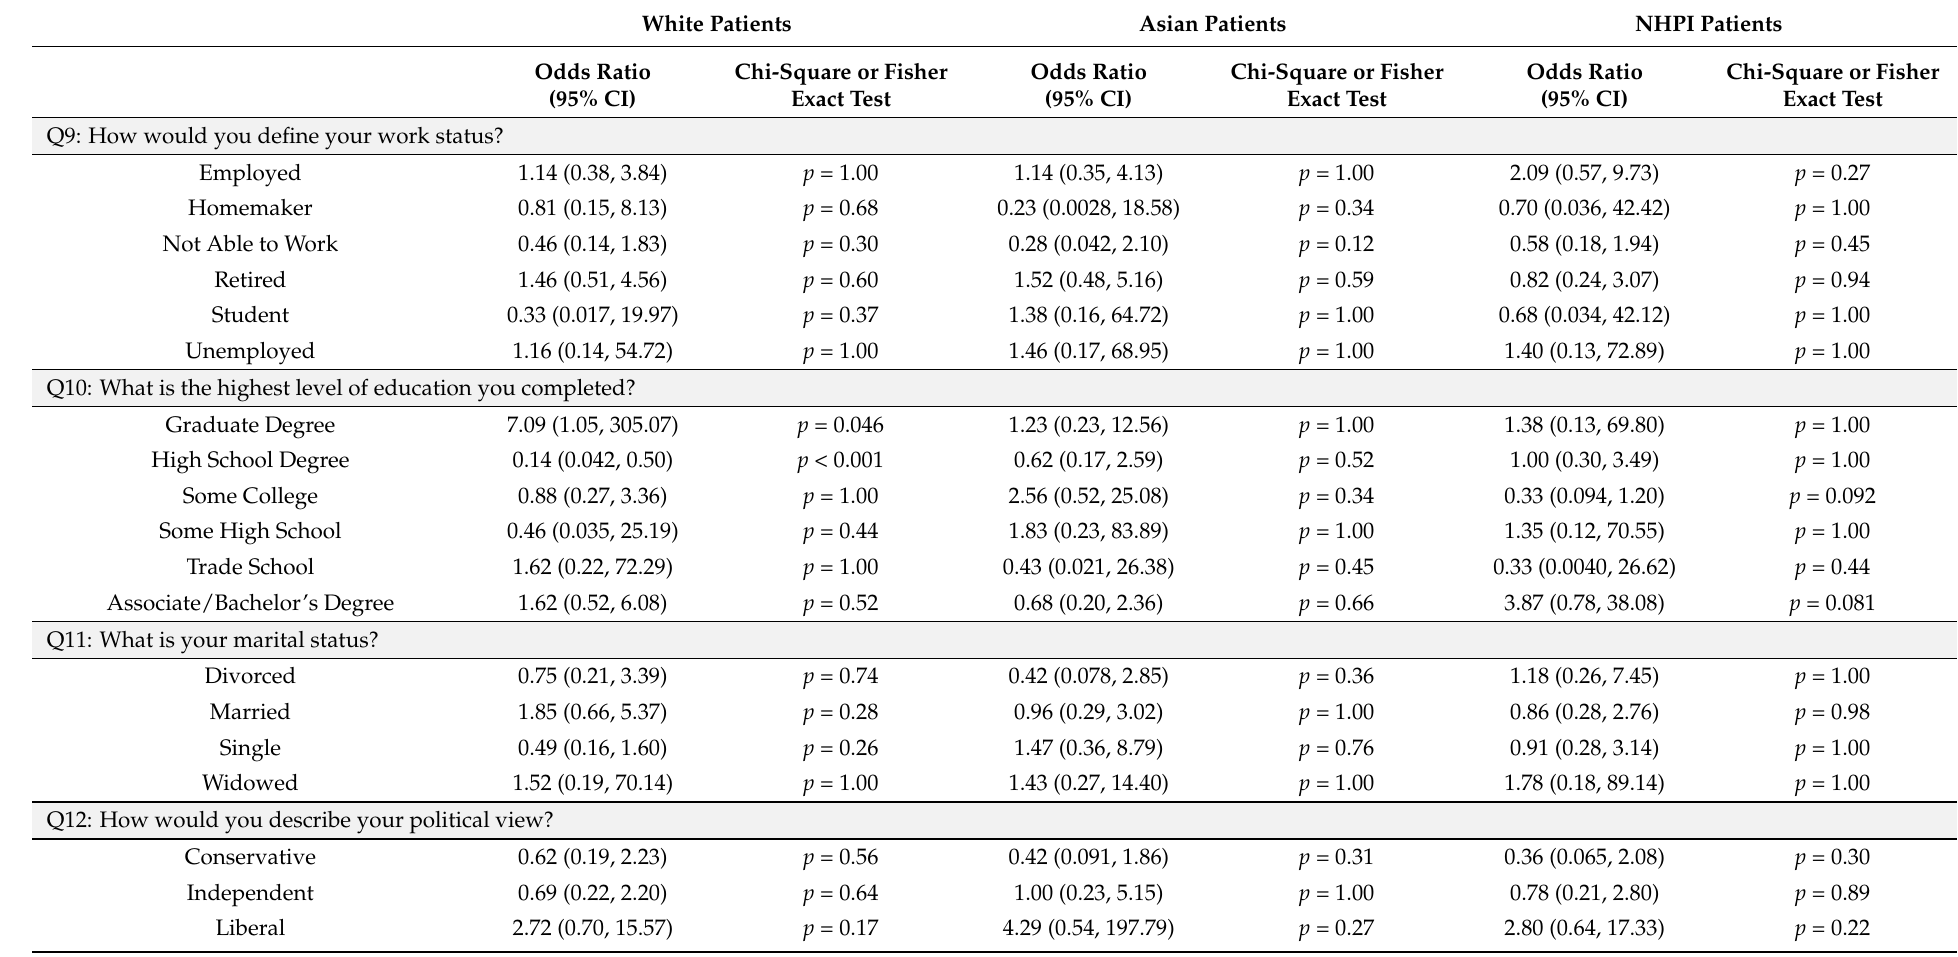
White Patients Asian Patients NHPI Patients